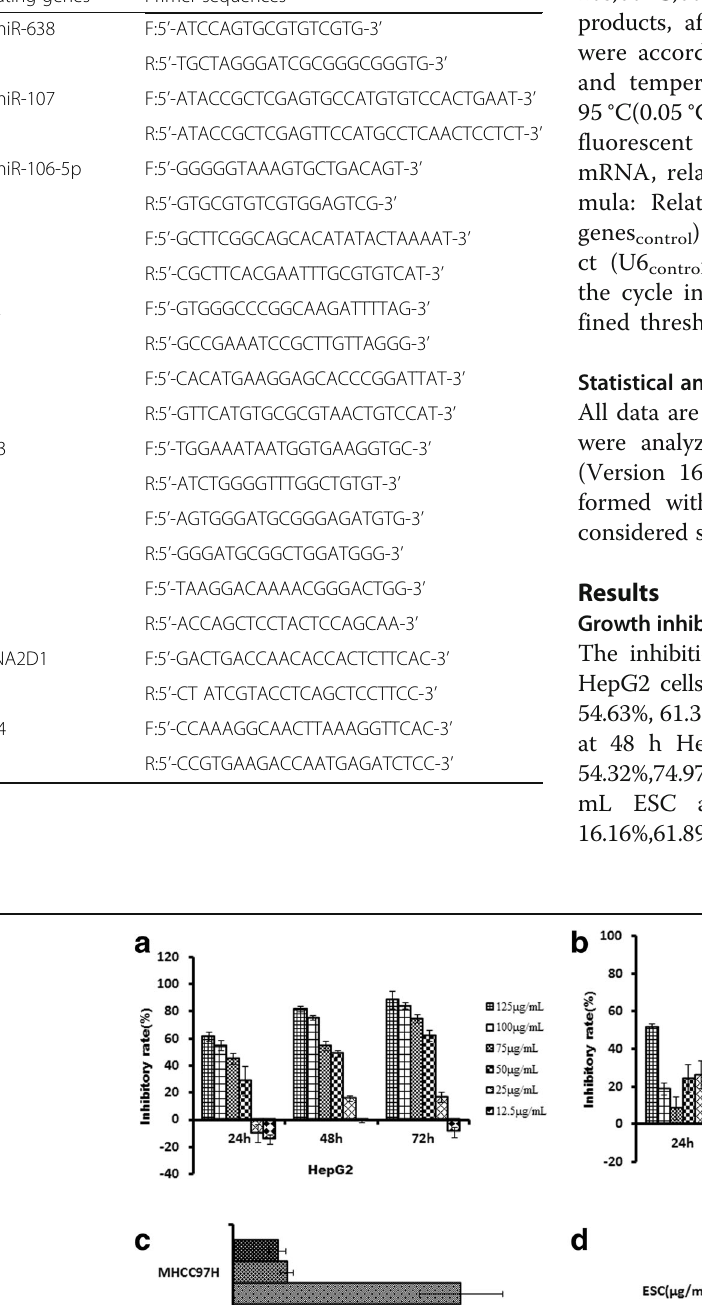
Validating genes Primer sequences